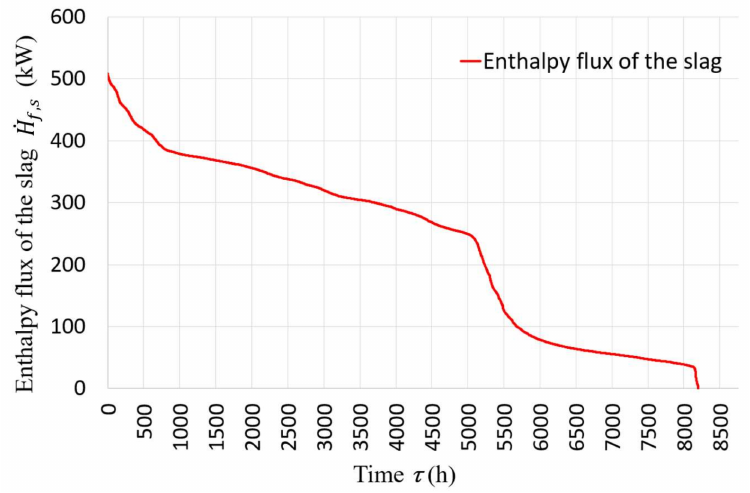
Figure 11. Annual distribution curve of enthalpy flux of the analyzed